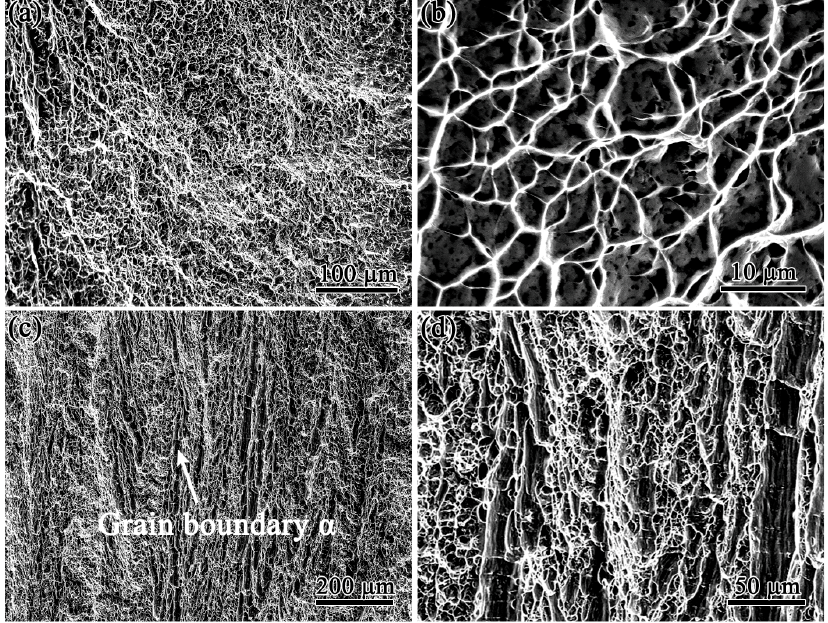
Figure 8. Fracture morphology of the fatigue-damaged samples after 20,000 pre-cycles: ( a ) Low- power and ( b ) high-magnification images of the H-charged sample. ( c ) Low-power and ( d ) high- magnification images of uncharged samples.